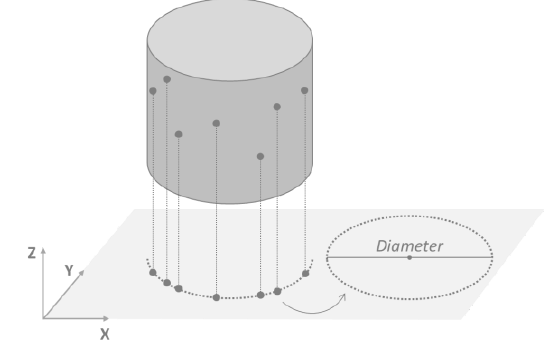
Figure 1. Arc described by the planimetric coordinates of the points on the trunk. A circle can be fitted to determine its diameter.